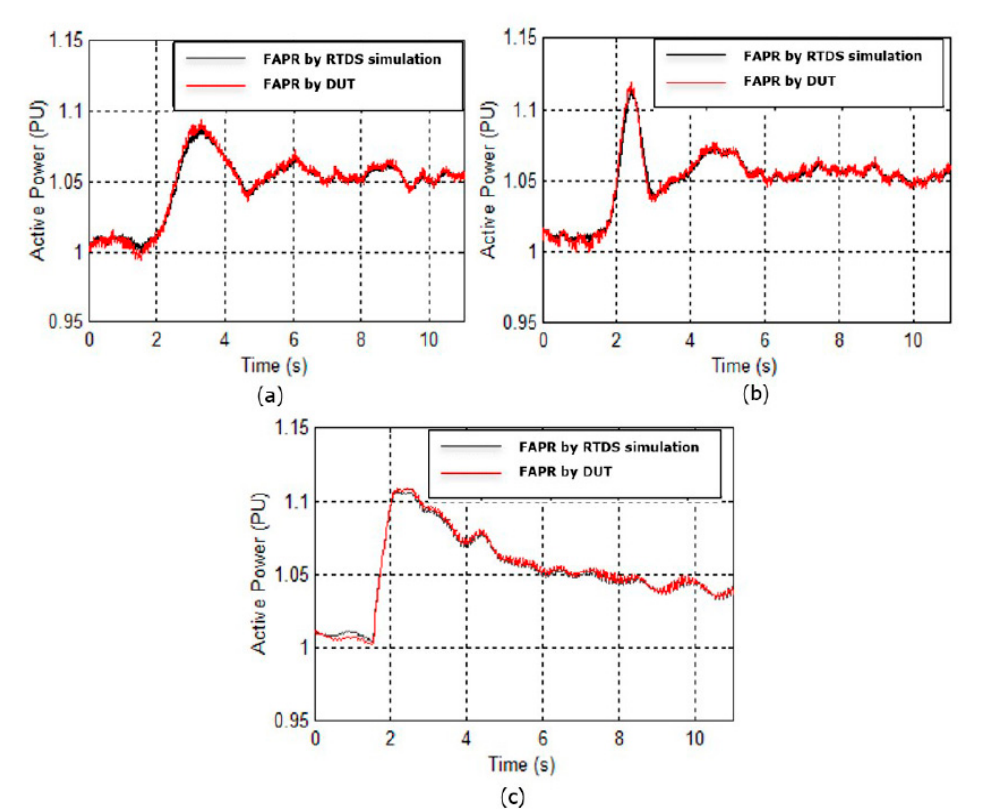
Figure 12. FAPR by simulated and DUT converters ( a ) with a droop controller; ( b ) with a derivative-based controller; and ( c ) with a VSP-based controller.